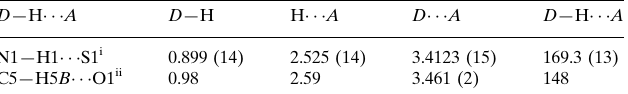
Hydrogen-bond geometry (A˚ , (cid:1)